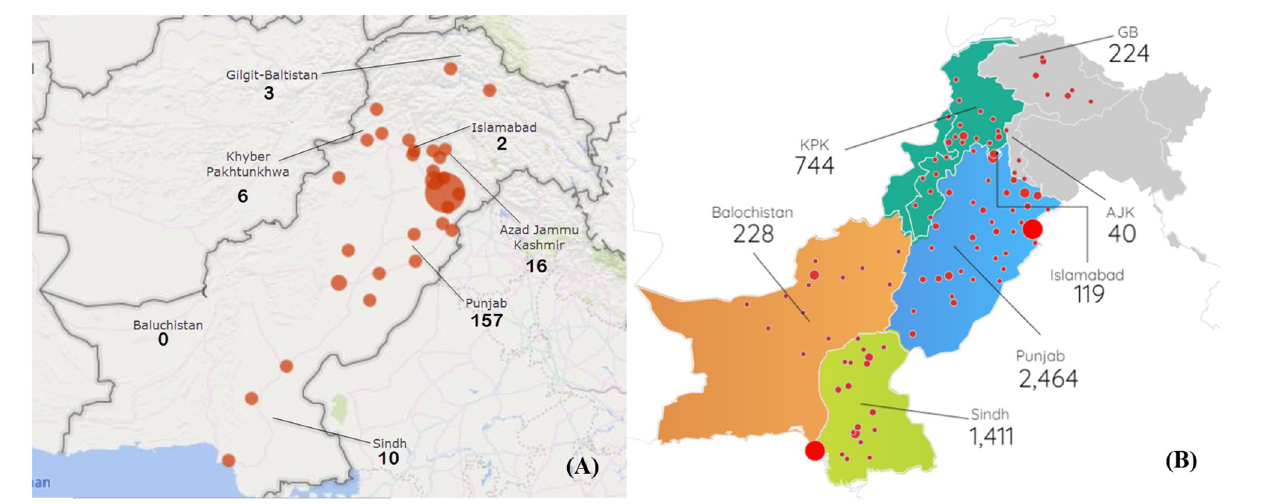
FIGURE 1 | (A) Depicts the sample data distribution throughout the country. (B) Represents the population data generated by Government of Pakistan. The size red dots represents the number of the patient data collected from each district in (A) whereas, the red dots in (B) represents the number of active patients. The values below each province name represents the number of